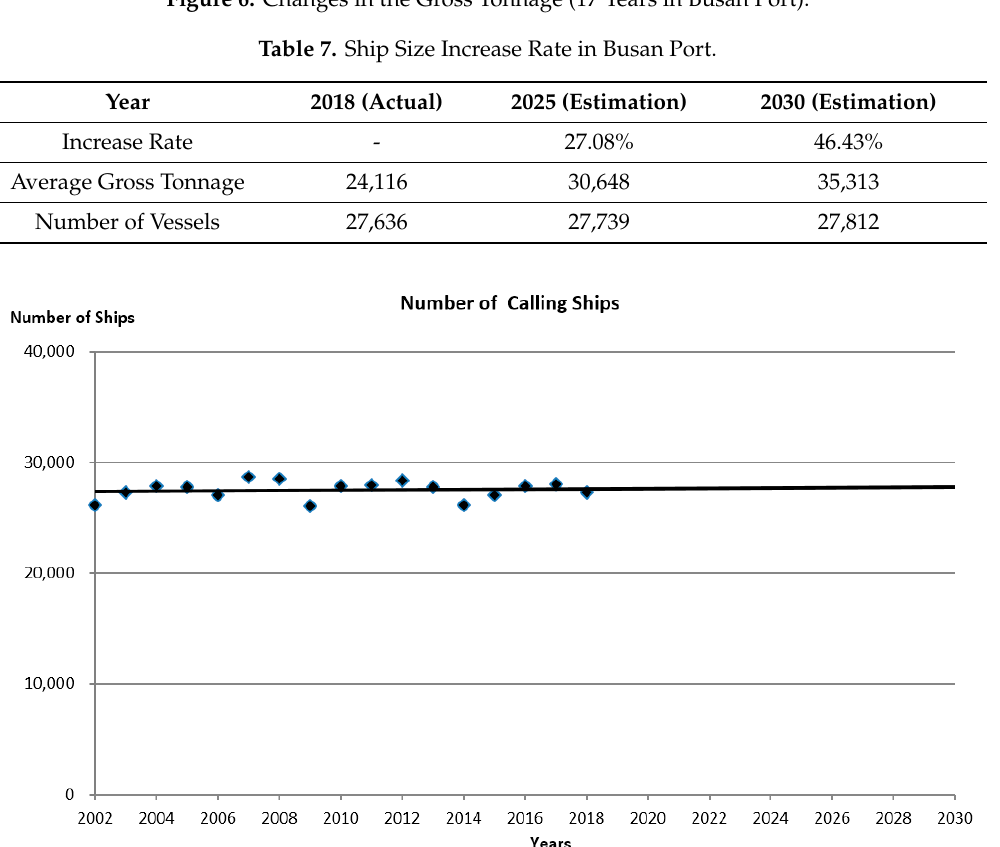
Table 7. Ship Size Increase Rate in Busan Port.